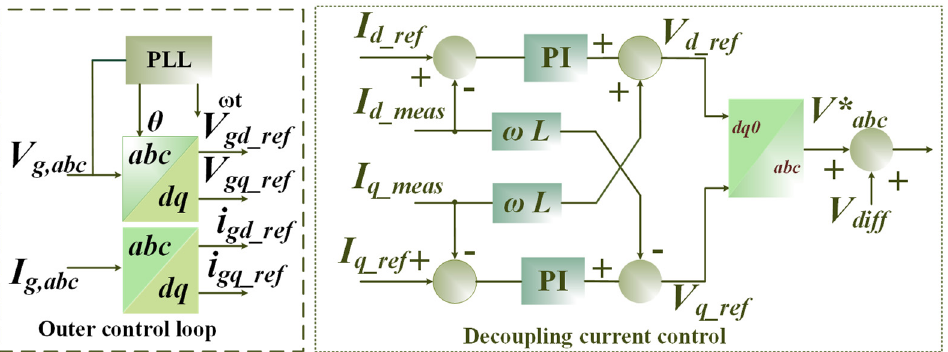
Figure 8. The architecture of inner control is based on decoupling current control.